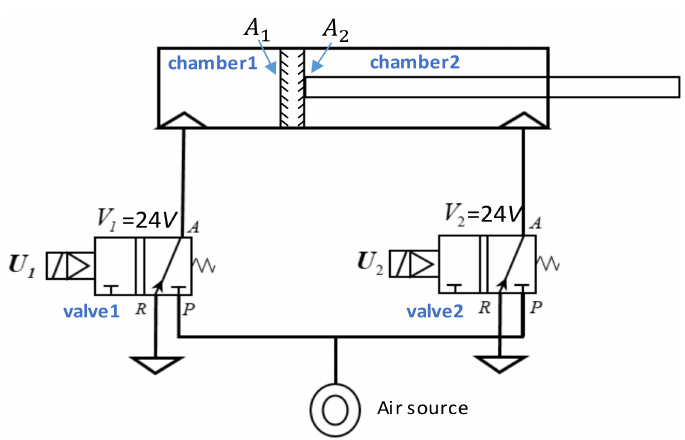
Figure 12. Diagram of a double-acting pneumatic cylinder